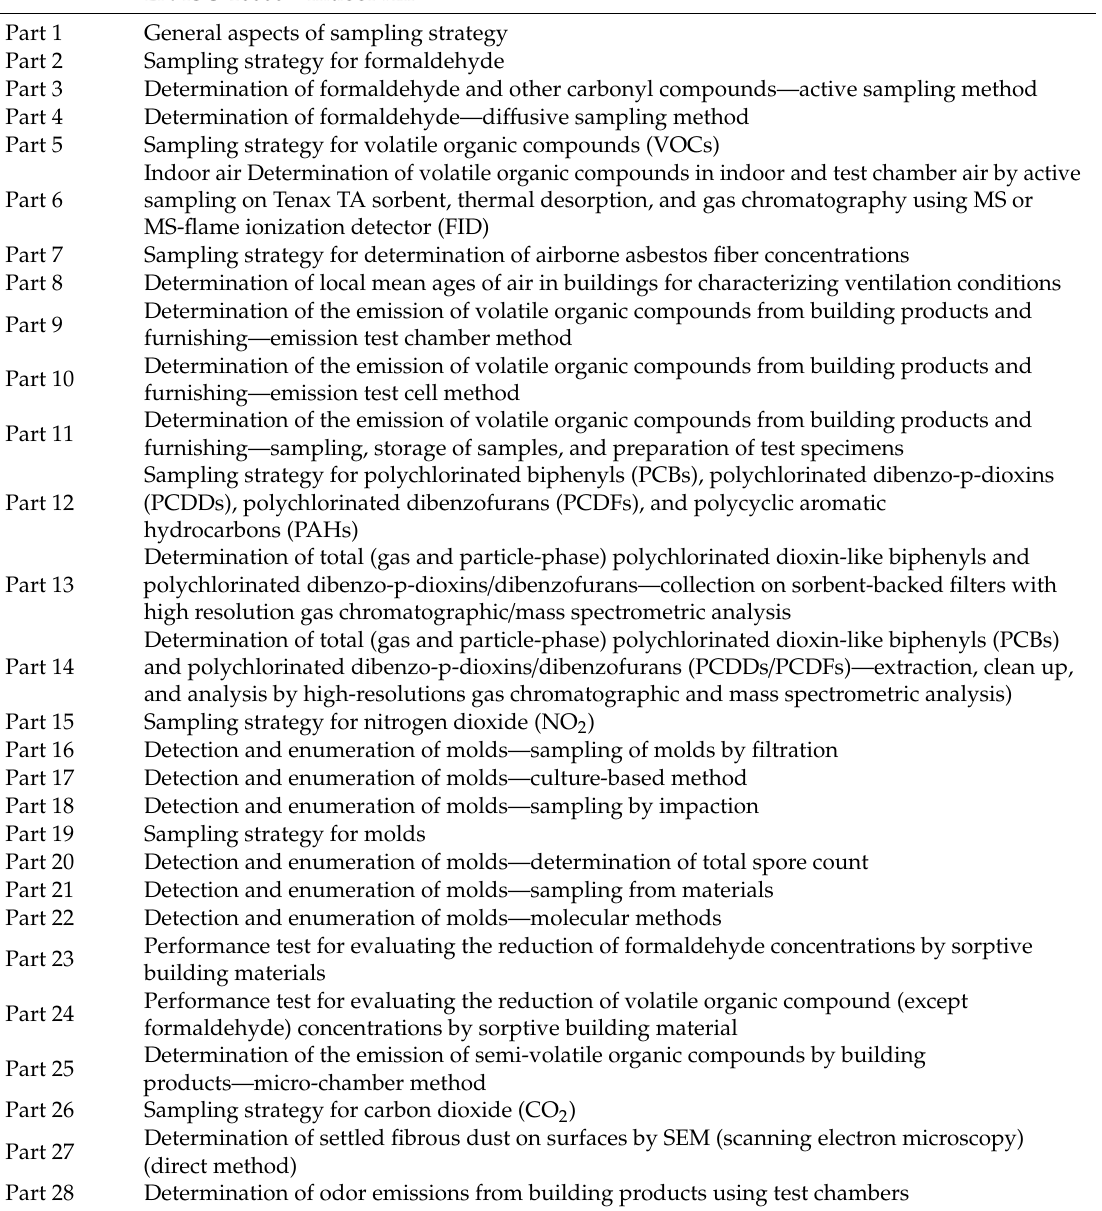
Table 1. List of International Organization for Standardization (ISO) 16000 series for IAQ. EN = European